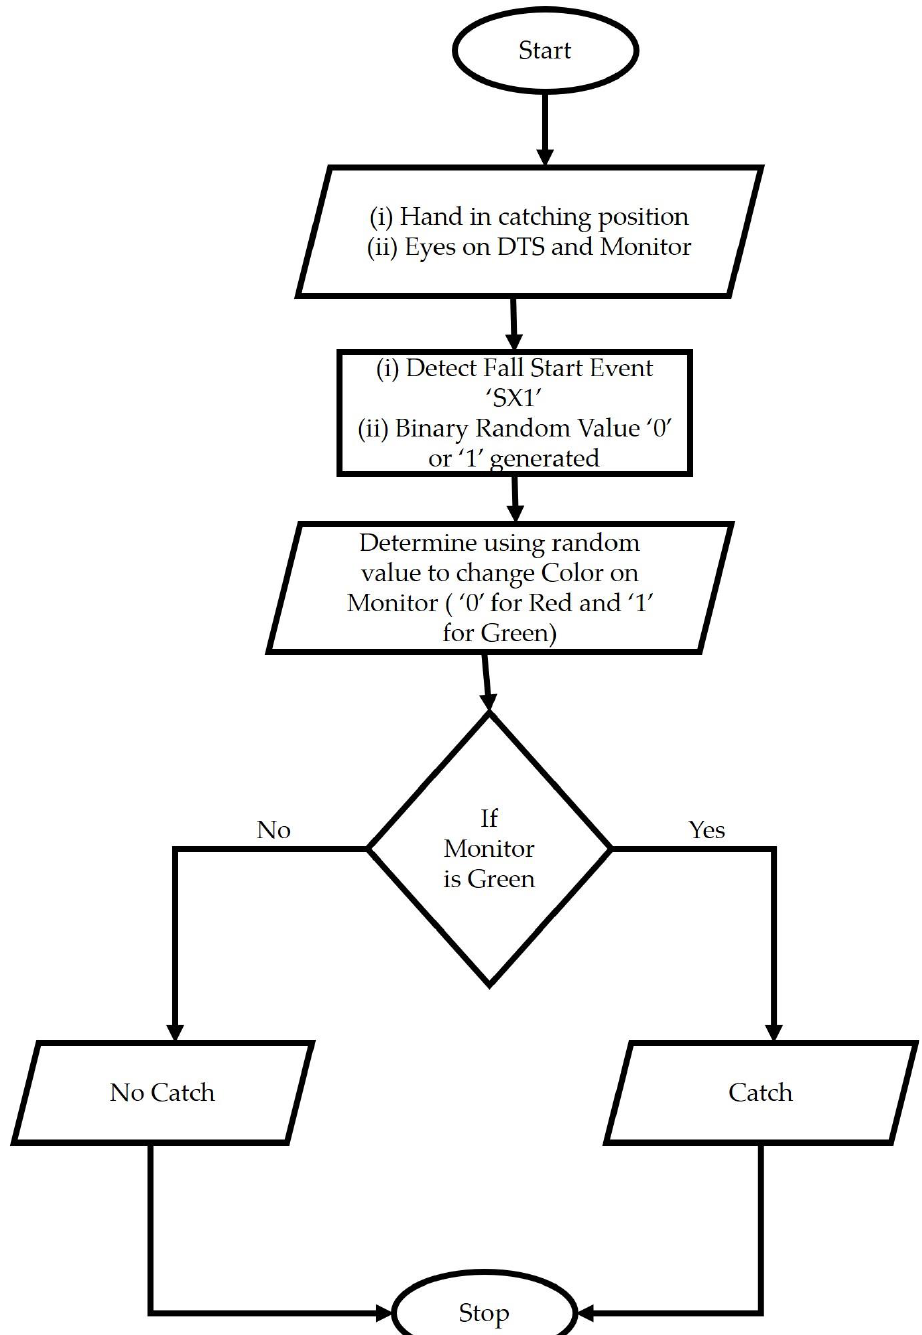
Figure 2. Schematic diagram showing how computer algorithm was created for dual-tasking con-